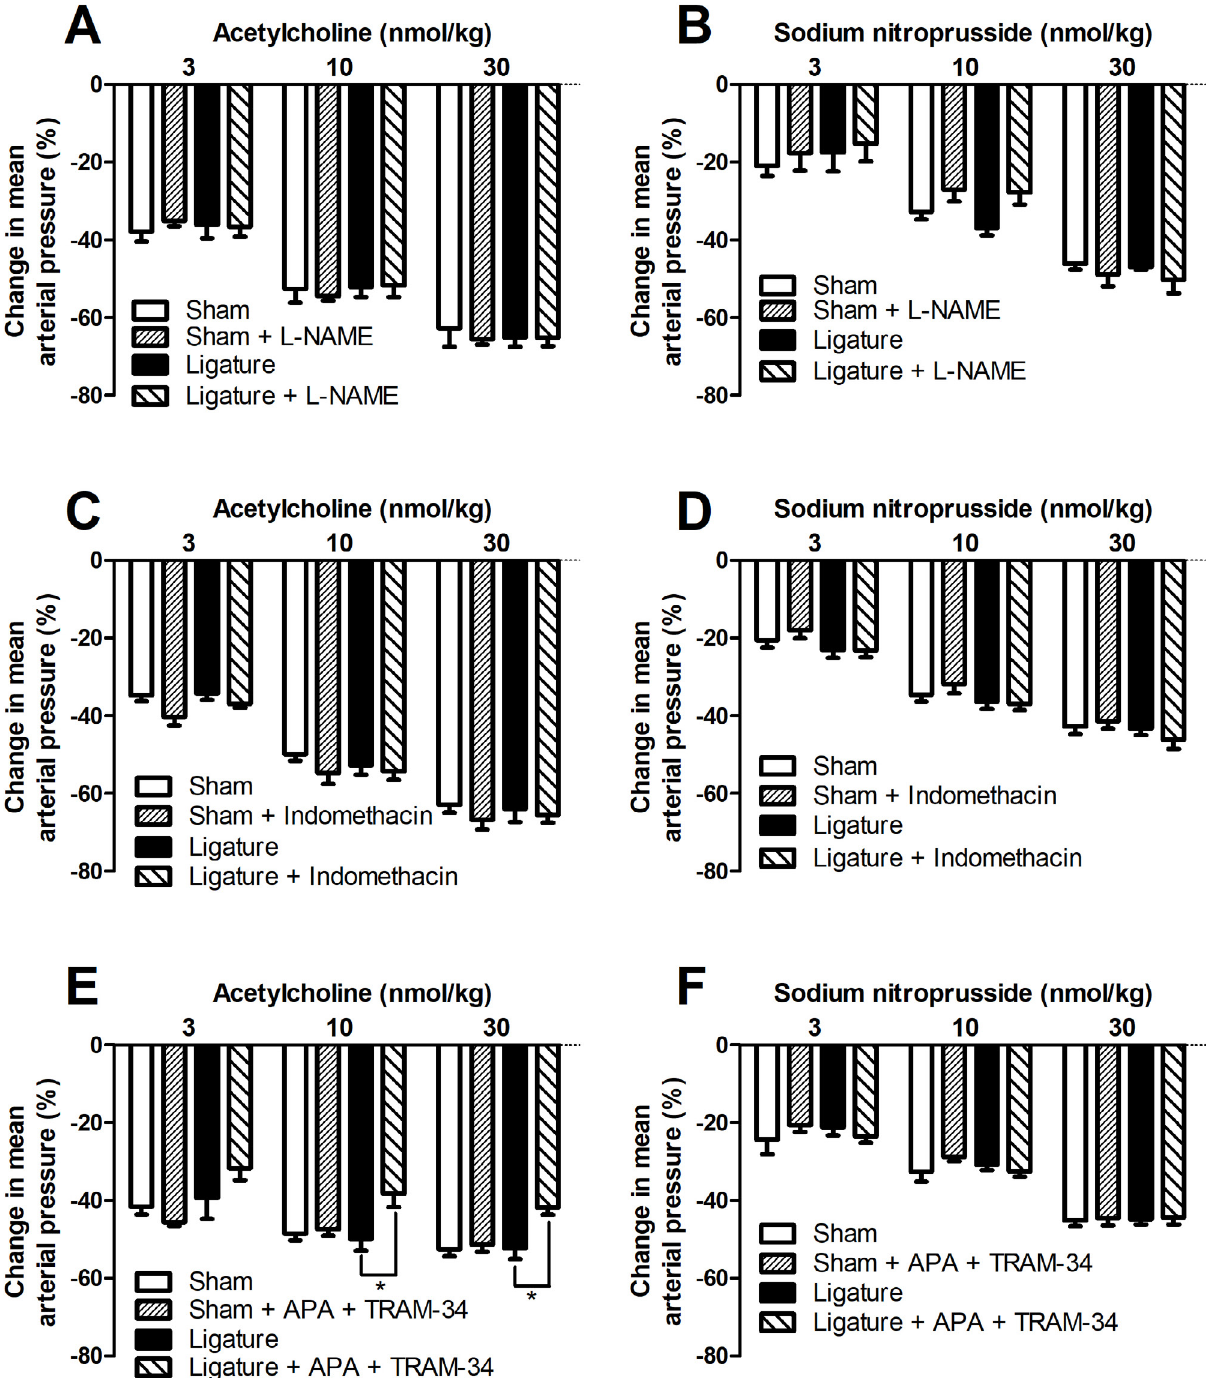
Figure 4- Involvement of NOS, COX, or EDH restoration of the acetylcholine-induced reduction in blood pressure. Twenty-one days after ligature or sham procedure, the animals were prepared for measurement of mean arterial pressure, and dose response curves to acetylcholine and sodium nitroprusside were performed before and 30 min after L-NAME (20 mg/kg, i.v; panels A-B), indomethacin (10 mg/kg, i.v; panels C-D) or apamin plus TRAM-34 (75 µg/kg and 1 mg/kg, respectively, i.v; panels E-F). The change in mean arterial pressure (% of decrease from basal blood pressure) was determined. Statistical analyses were performed using two-way analysis of variance followed by Bonferroni post hoc test.